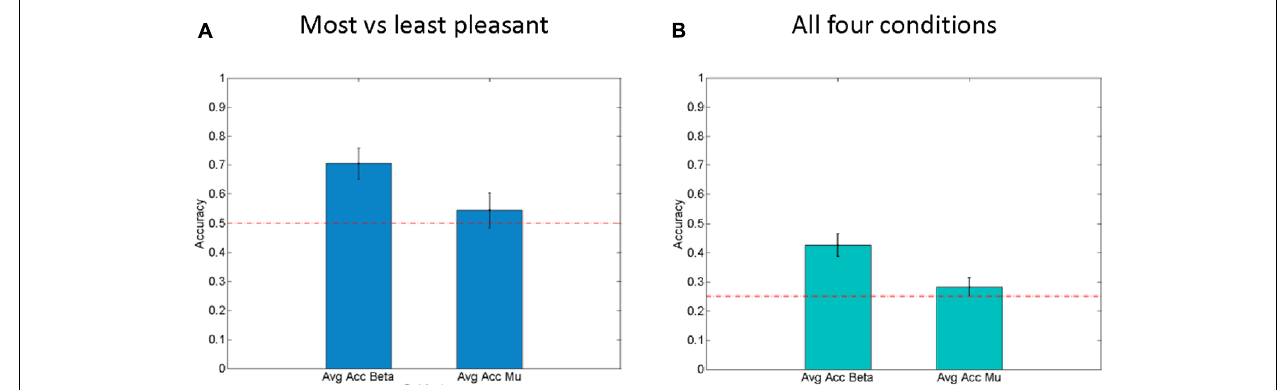
the horizontal line. (B) Average results for fivefold cross validation for Single Trial level predictions of all four conditions using both beta modulation (left) and mu-suppression features. Standard error of the mean is shown as error bars. Chance level (0.25) is indicated as horizontal